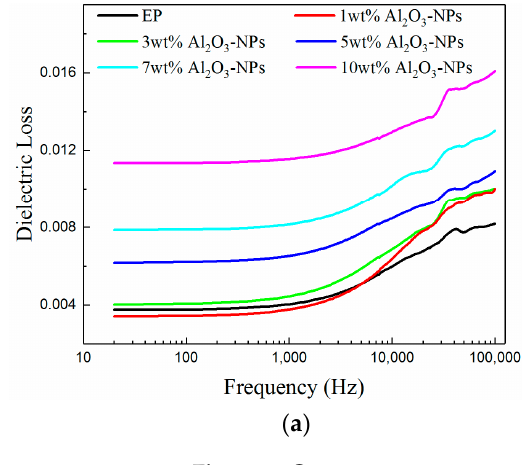
Figure 7. Change in the dielectric constants of the composites of different mass fractions of Al 2 O 3 nano-fillers with frequency: ( a ) Al 2 O 3 -NPs, ( b ) Al 2 O 3 -NWs, ( c ) Al 2 O 3 -NPLs, and ( d ) dielectric constants of the composites as a function of filler content measured at room temperature and 1